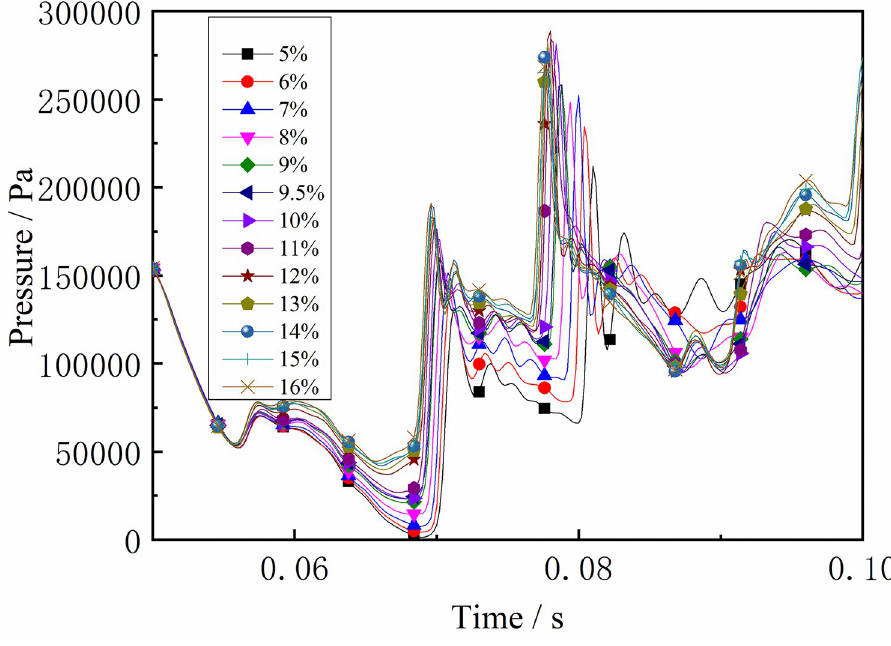
Fig 16. Pressure—Time curves and peak at monitoring point 7 at different gas concentrations (sequence chart).